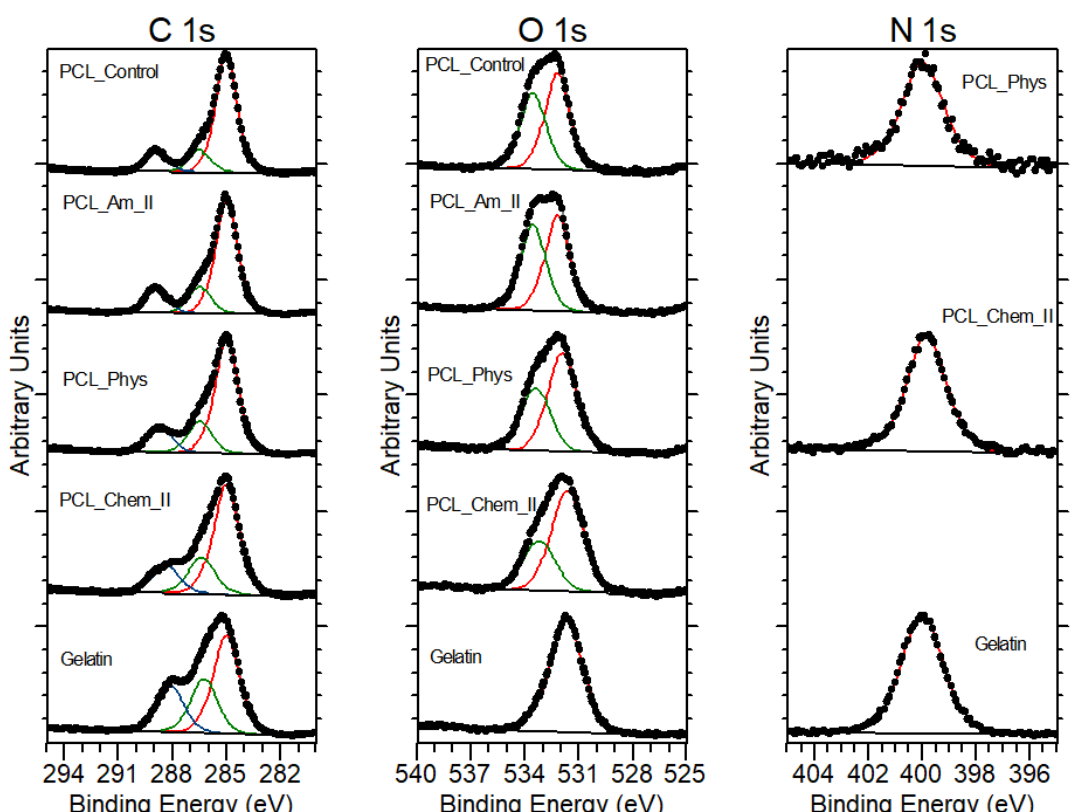
Figure 4. XPS spectra of PCL_Control, PCL_Am_II, PCL_Phys, PCL_Chem_II and gelatin.